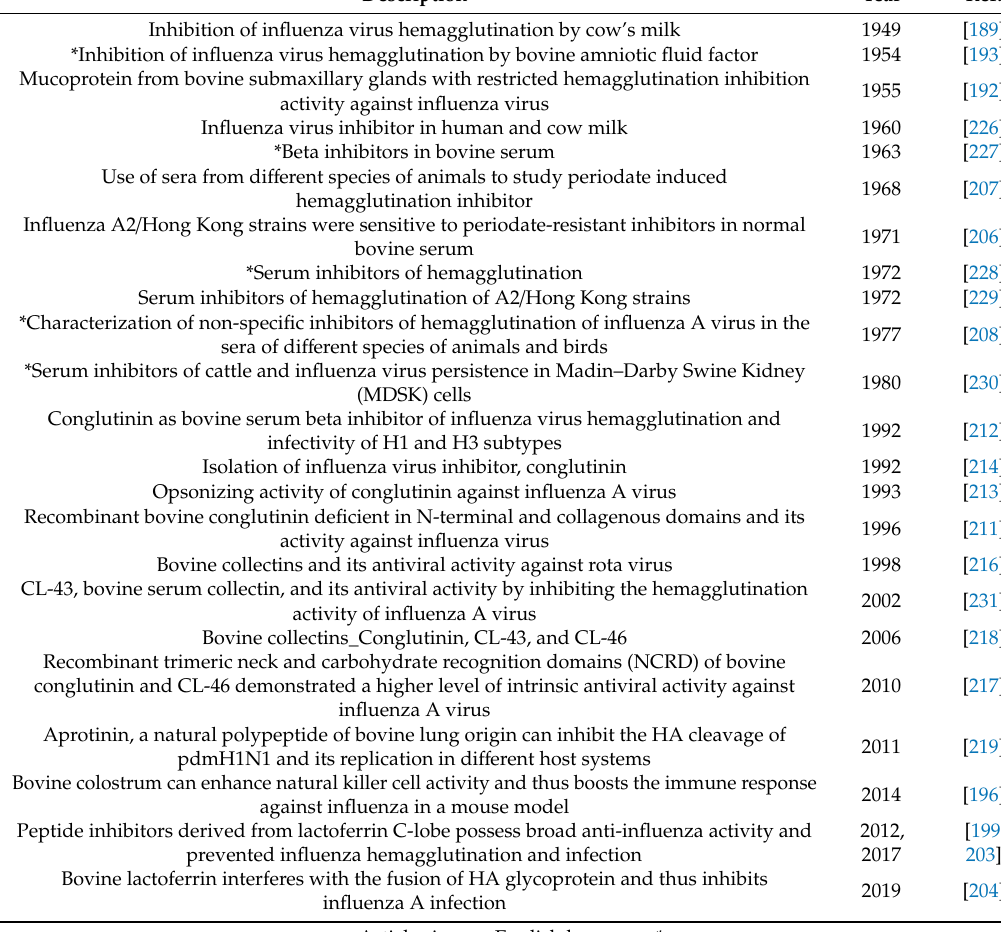
Table 4. Summary of major bovine host antiviral factors and their interactions with